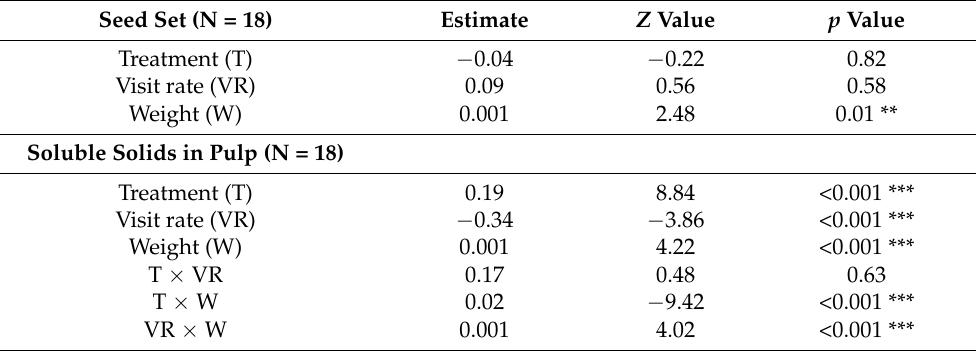
Table 2. Summary of the GLM effect of treatment, visit rate, fruit weight, and its interaction terms on seed set and soluble solids in the pulp of Cucurbita maxima . N represents sample size. * p < 0.05, ** p < 0.01, *** p < 0.001.